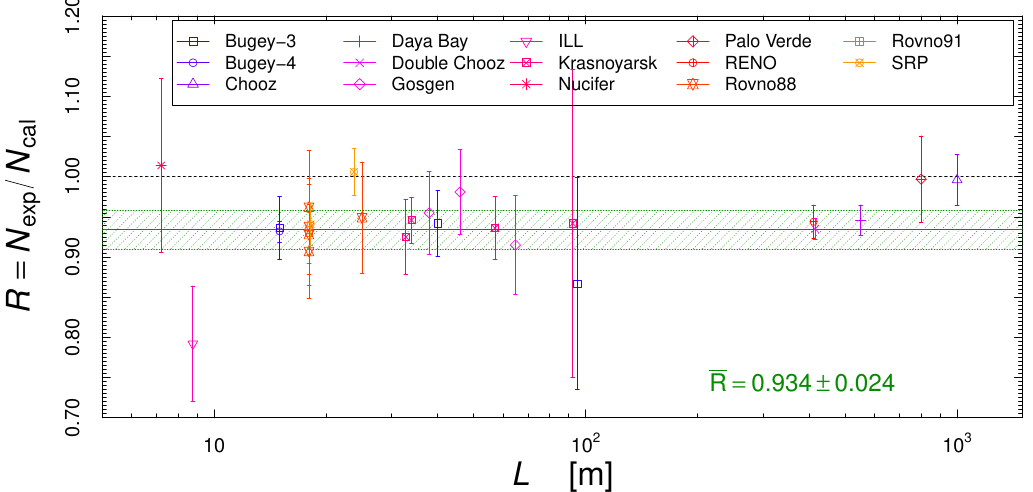
Figure 1 . Ratios R of the reactor experiments considered in our analysis as functions of the reactor-detector distance L . The horizontal band shows the average ratio R and its uncertainty. The error bars show the experimental